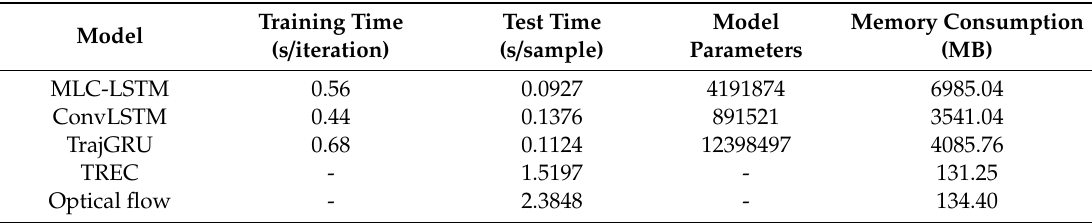
Table 7. Performance evaluation results of the MLC-SLTM, ConvLSTM, TrajGRU, TREC, and Optical